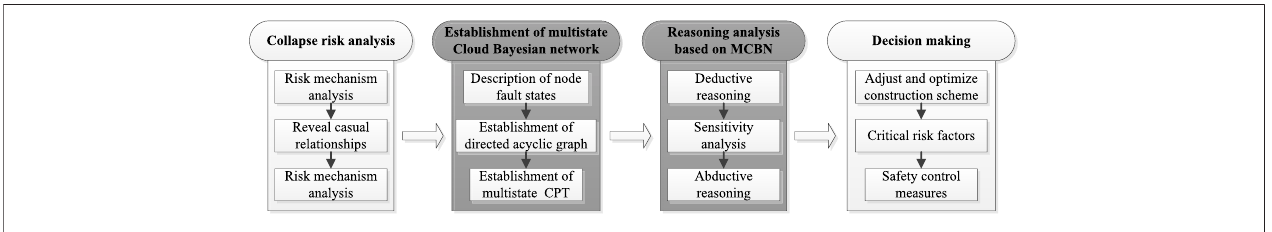
FIGURE 1 | Flowchart of the multistate cloud Bayesian network.